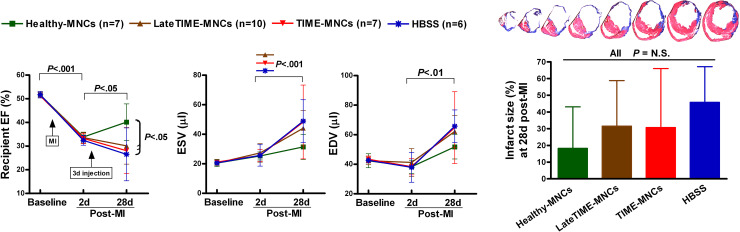
Impaired therapeutic efficacy of post-MI patient BM MNCs from the TIME and LateTIME clinical trials.Post-MI MNCs were similar to HBSS vehicle control in their lack of beneficial effect on recipient cardiac function, whereas healthy MNCs improved LVEF and minimized ventricular chamber dimensions such that ESV in only the healthy donor group was not significantly increased, with a non-significant difference between EDV from recipients of healthy cells vs. the other groups. Infarct size at 28 days post-MI showed a trend toward higher values in the post-MI donor groups and HBSS vehicle group as compared to the healthy donor group, although no significant differences were reached (P = 0.925–1.00). A representative series of stained sections cut from apex to base is presented as an example of our typical histology for these measurements; the infarct size in the ventricle shown (extent of blue scar relative to viable tissue) was 55%. Error bars = SD.